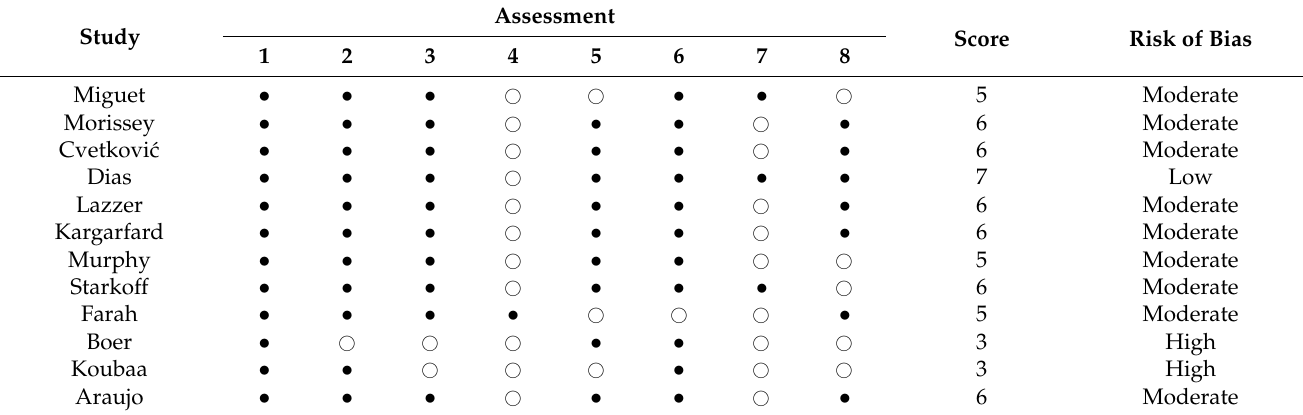
Table 2. Risk of bias assessment of the included